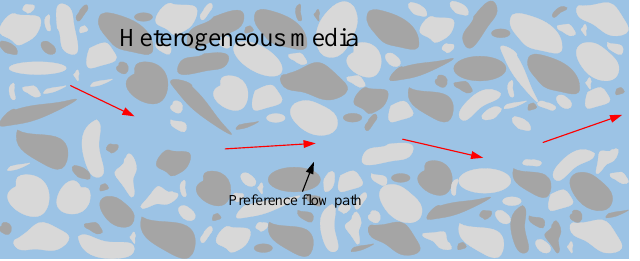
Figure 1. Conceptual map of preference flow path in heterogeneous media, the preferential flow path is drawn with red